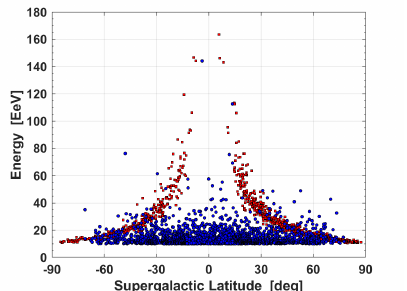
Figure 3. Toy-model supergalactic magnetic sheet simulation. Blue circles are the F = 65 . 7% isotropic fraction of MC events. Red squares are the anisotropic MC events magnetically di ff used away from the supergalactic plane with S ∗ B = 18 . 47 kpc ∗ µ G. Overall, event positions are isotropic and the energy spectrum is created according to the published HiRes / TA